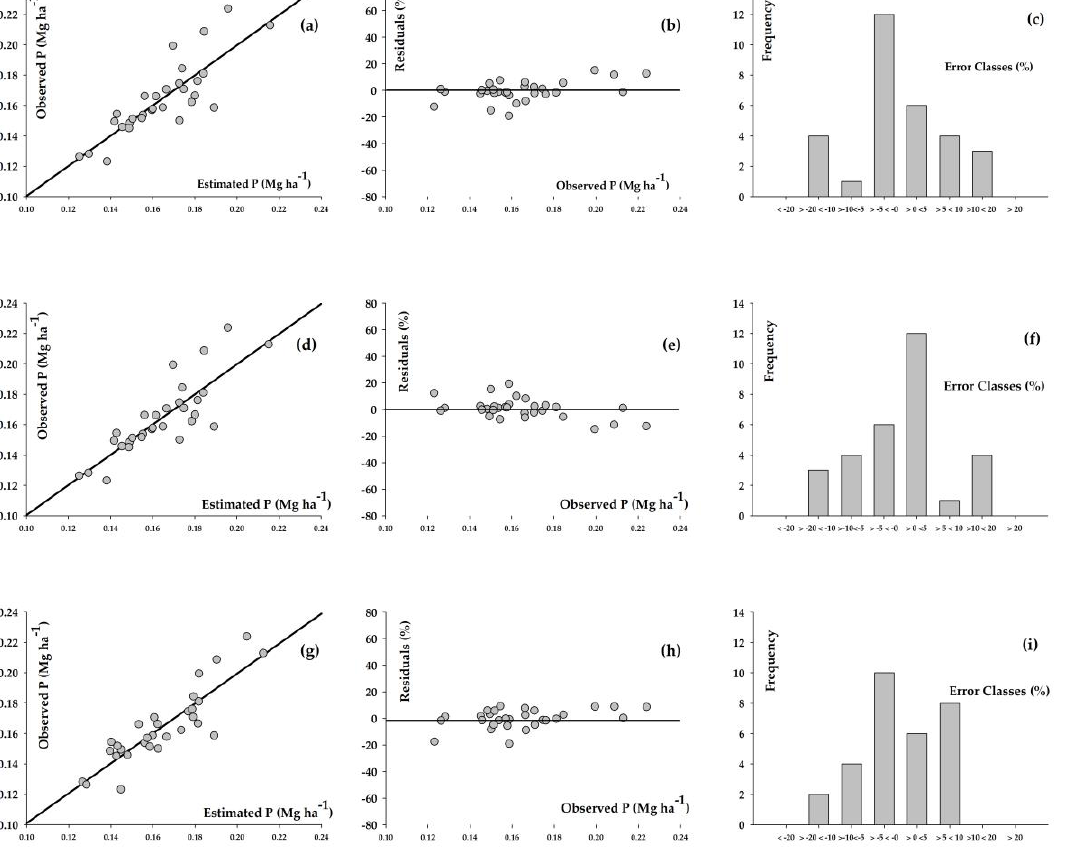
Figure 4. Dispersion of estimated value by observed value, dispersion of residues, and distribution in error classes obtained for the phosphorus adjustments (mg ha − 1 ) using non-linear models, where ( a – c ) refer to the Richards model, ( d – f ) to the Weibull model, and ( g – i ) to the Schumacher–Hall model. Table 8. Statistical parameters of the non-linear models obtained in the adjustment of the amount of potassium in the eucalypt stand.